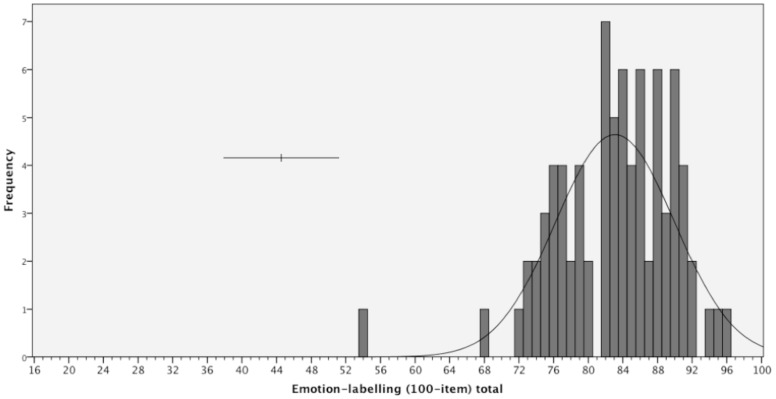
Frequency distribution for scores on the 100-item Emotion-labelling task (chance performance = 8).Error bars indicate 95% confidence interval of individual scores based on task reliability.